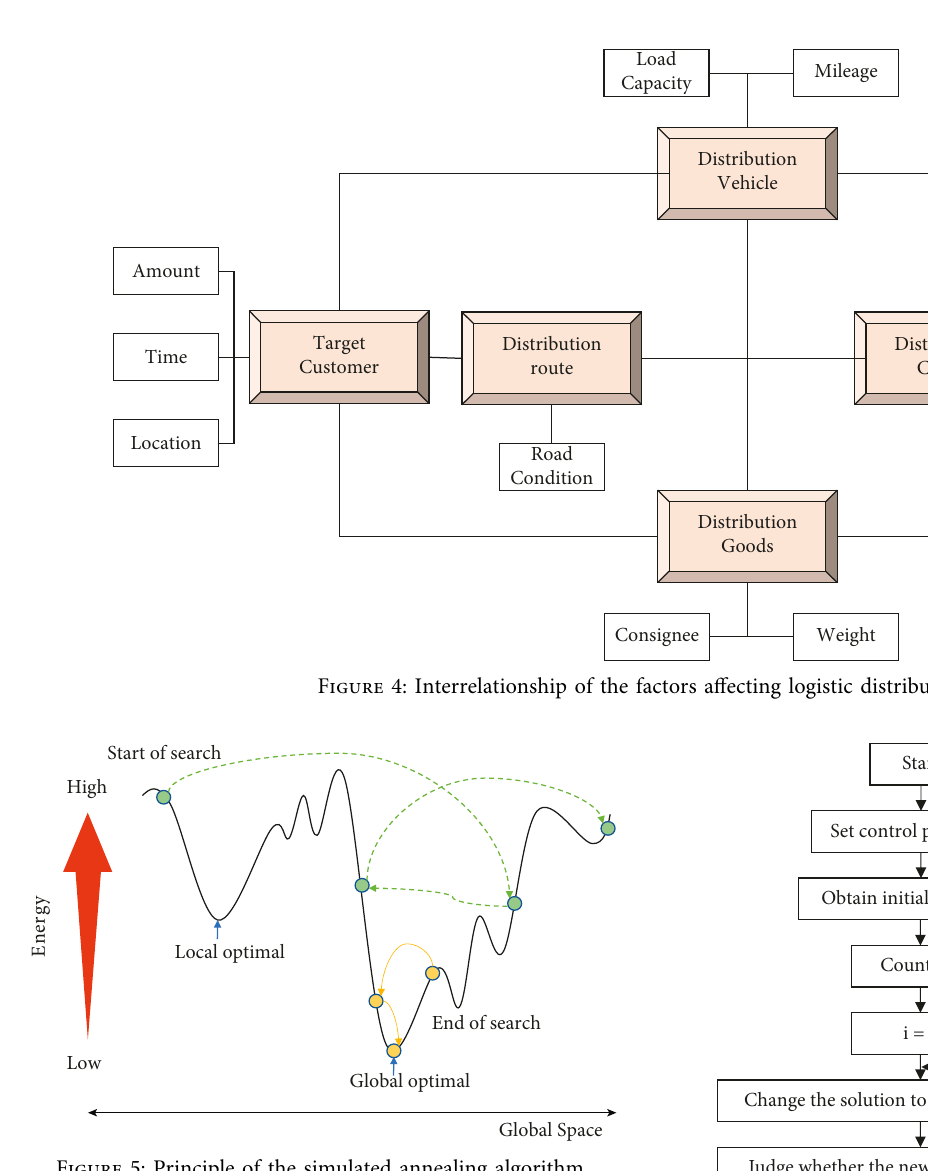
Figure 5: Principle of the simulated annealing algorithm.